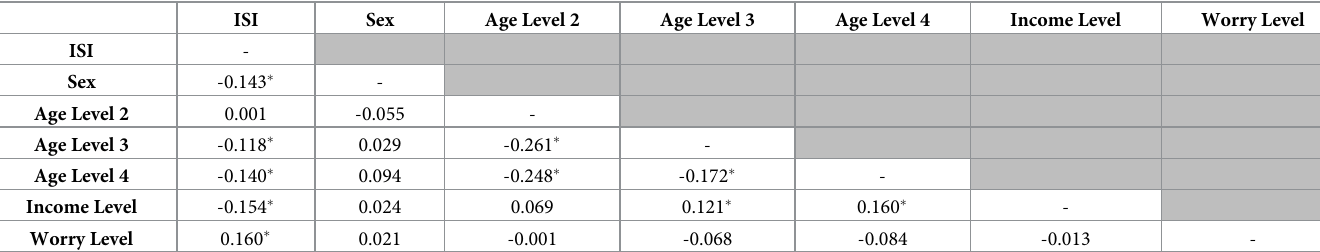
Table 3. Pearson correlations among the variables of interest ( � p < 0 . 05 ).